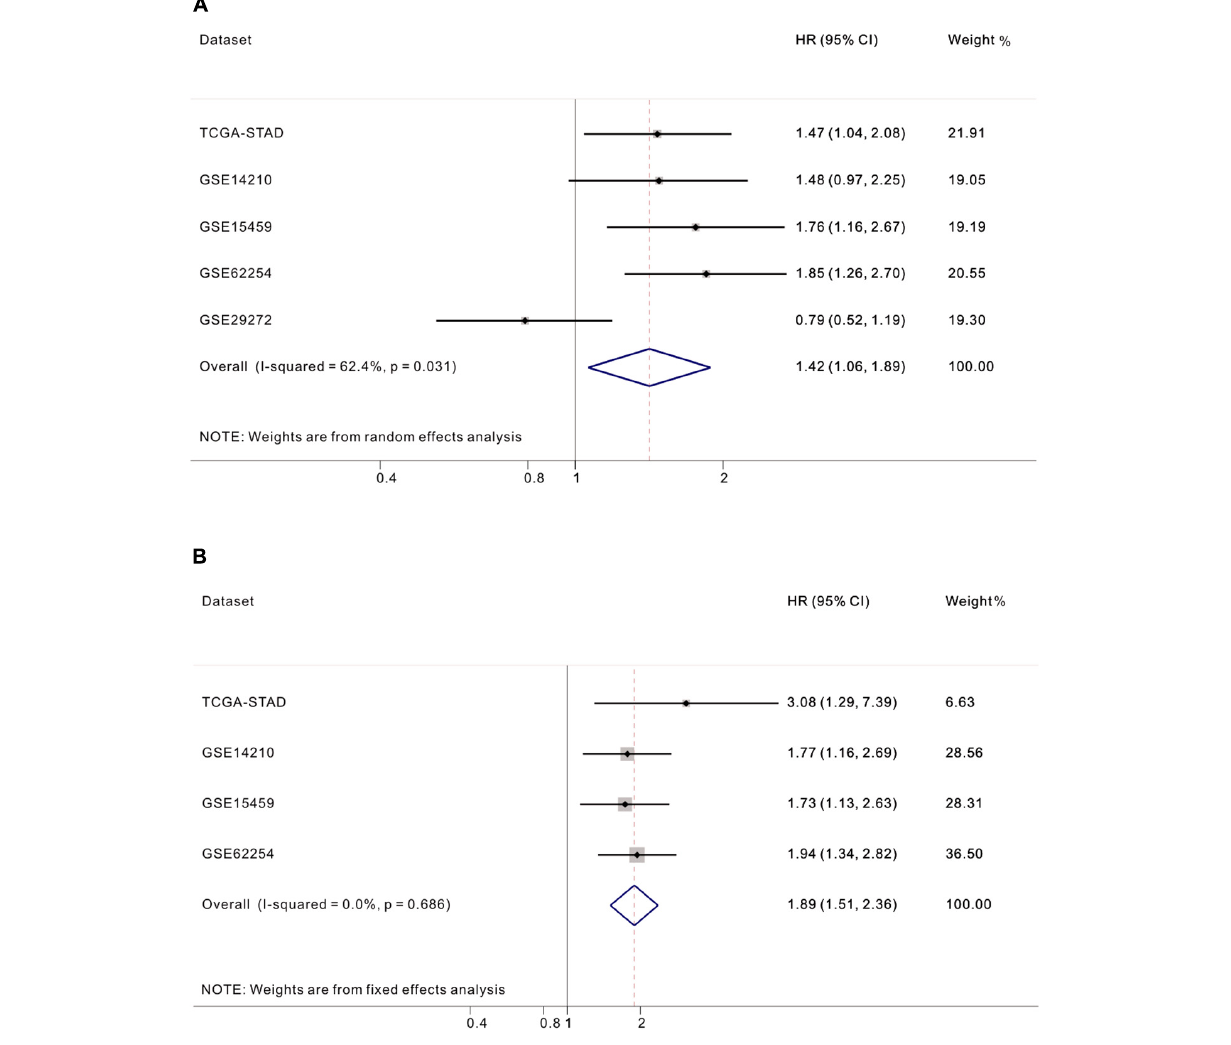
FIGURE 4 | Forest plot of overexpression of AMAP1mRNA associated with poor survival in gastric cancer patients. Overall survival (A) , Progression-free survival (B)